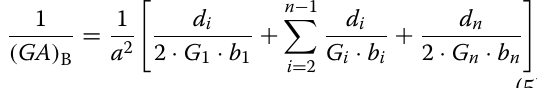
Fig. 4 Relations between nominal shear stress and displacement. Upper: three-point-bending test, 5L5P, l ef / d asymmetric-four-point-bending test, 5L5P, l ef / d